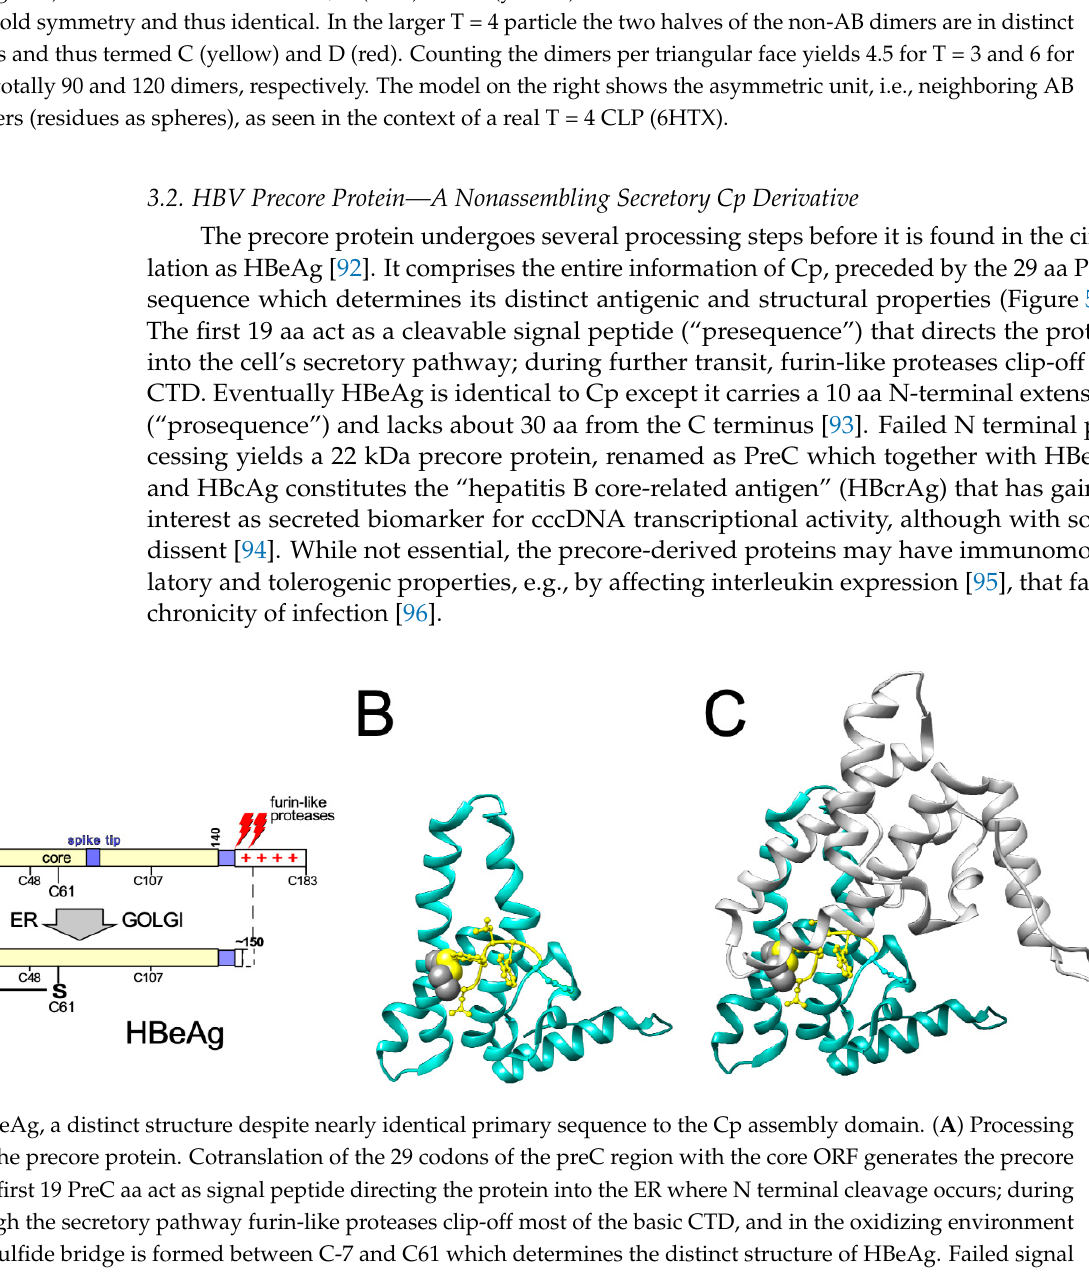
on formation of a four-helix-bundle by the α 3/ α 4 hairpins from two monomers, generating a prominent spike; in addition, the N terminal sequences embrace the spike base, as is most easily seen in the top view. ( C ) Cp dimer assembly into icosahedral capsid shells. On the left an icosahedron with its defining 2-fold, 3-fold, and 5-fold symmetry axes at one of the 20 triangular faces is shown. Cartoons in the center show the arrangement of Cp dimers in T = 3 and T = 4 particles. A subunits (green) cluster around 5-fold axes, B (blue) and C (yellow) subunits around 3-folds. The two C subunits are related by 2-fold symmetry and thus identical. In the larger T = 4 particle the two halves of the non-AB dimers are in distinct environments and thus termed C (yellow) and D (red). Counting the dimers per triangular face yields 4.5 for T = 3 and 6 for T = 4, hence totally 90 and 120 dimers, respectively. The model on the right shows the asymmetric unit, i.e., neighboring AB and CD dimers (residues as spheres), as seen in the context of a real T = 4 CLP (6HTX).